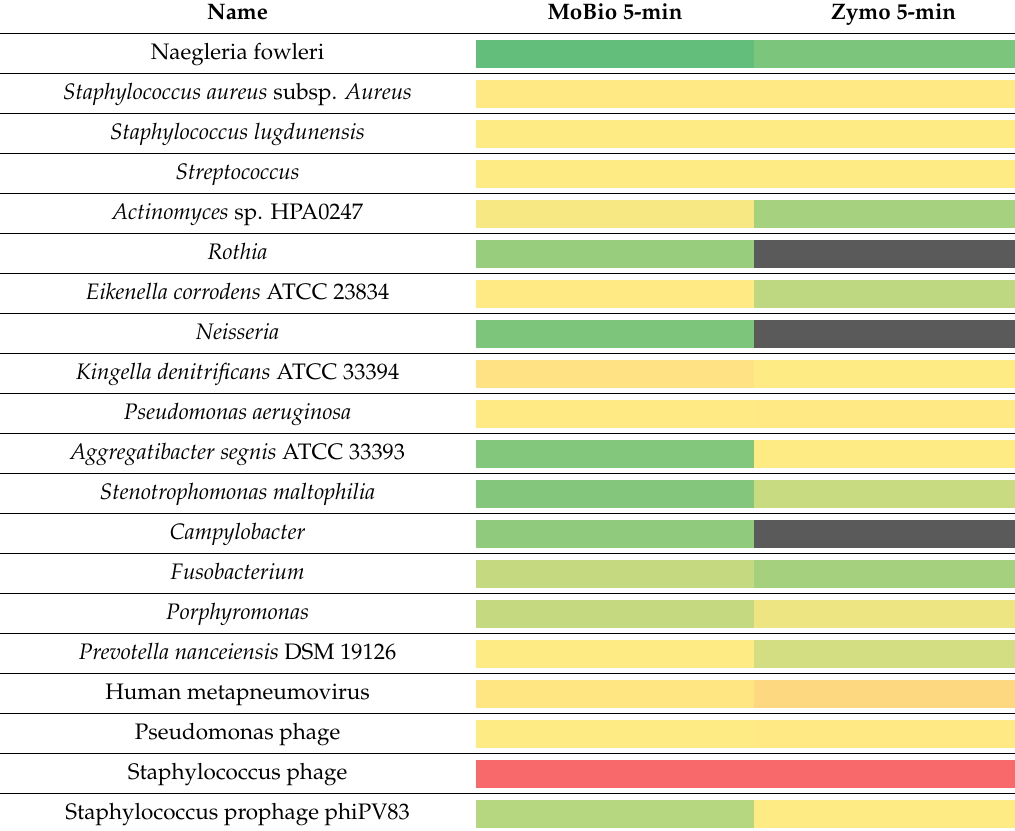
Table 7. Heat map shows a comparison of MoBio protocol and Zymo protocol yields after 5-min bead beating based on the abundance of microbes detected from the CosmosID